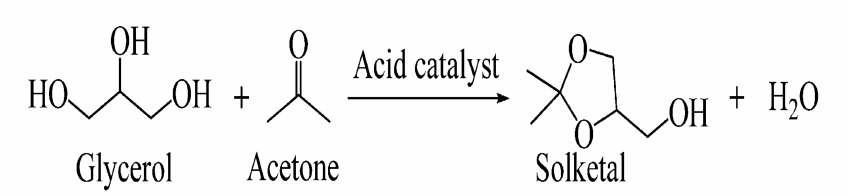
Figure 1. Ketalization of glycerol for solketal